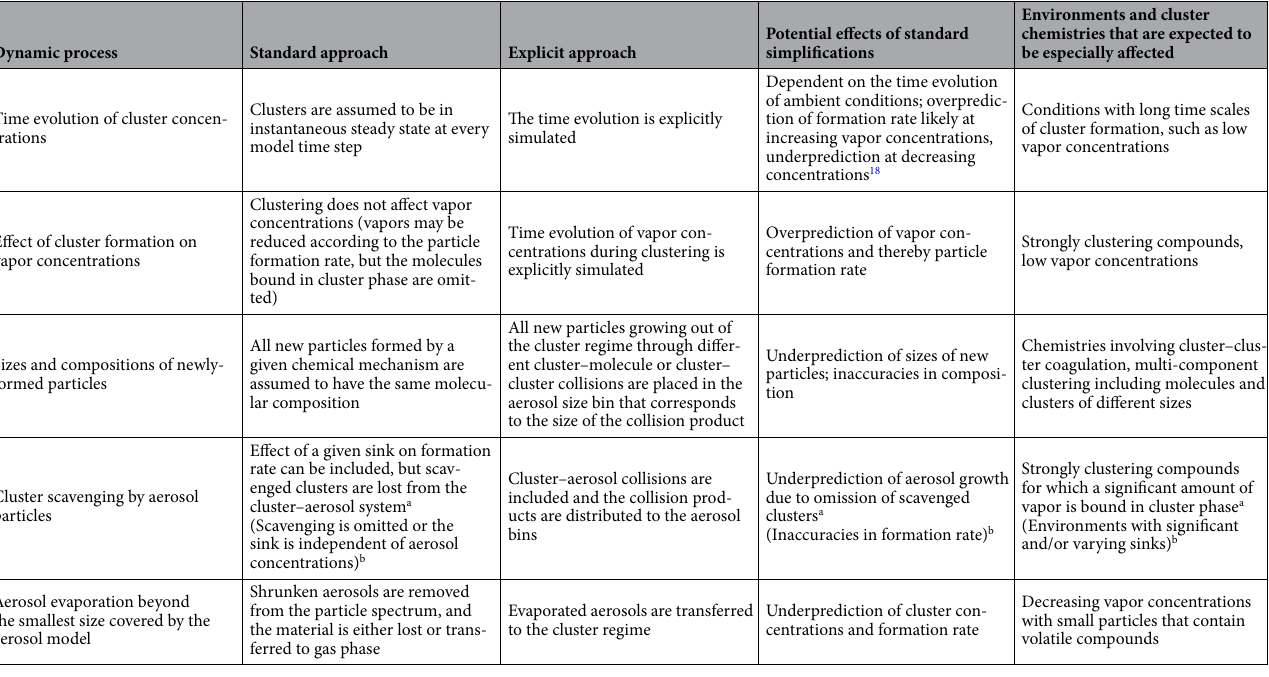
Table 1. Treatment of different molecular cluster dynamics processes in the standard approach and in the explicit approach developed in this work. The listed potential effects of the standard simplifications are general examples, and the effects can be more diverse over various atmospheric conditions. a Applied here (see “Methods”). b The simplest approach for cluster scavenging, relevant to simplified theories (e.g. classical nucleation theory) or experimental formation rates determined at constant